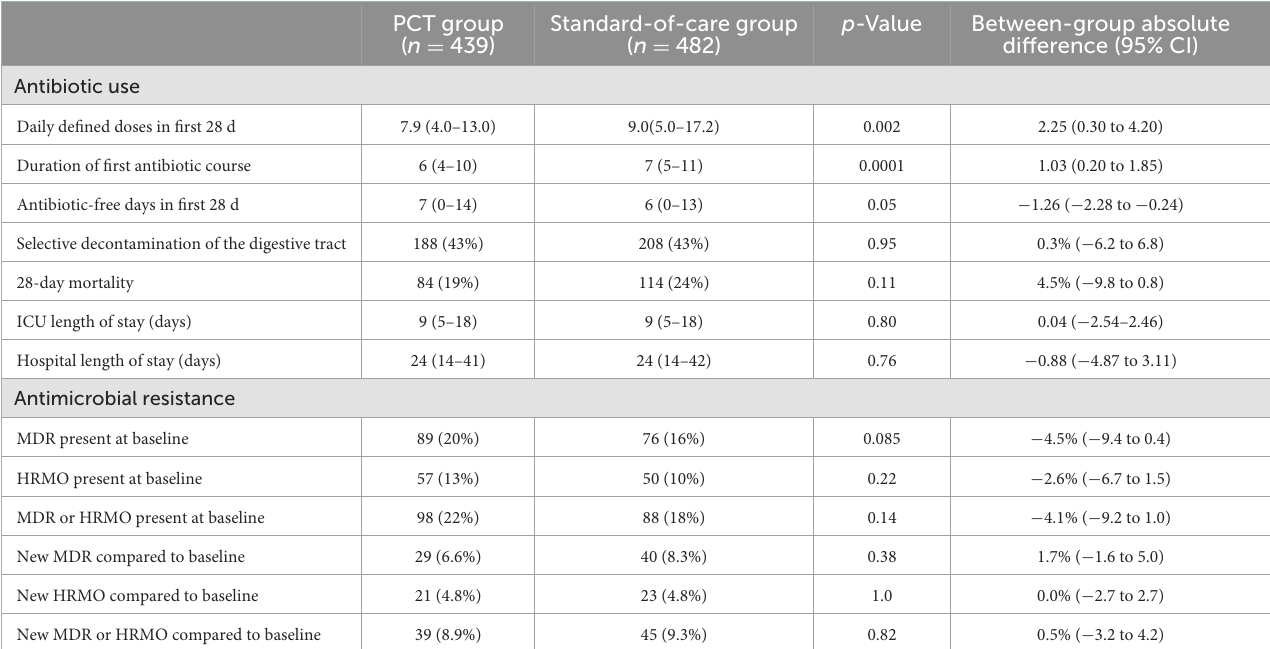
p -Value Between-group absolute difference (95% CI)